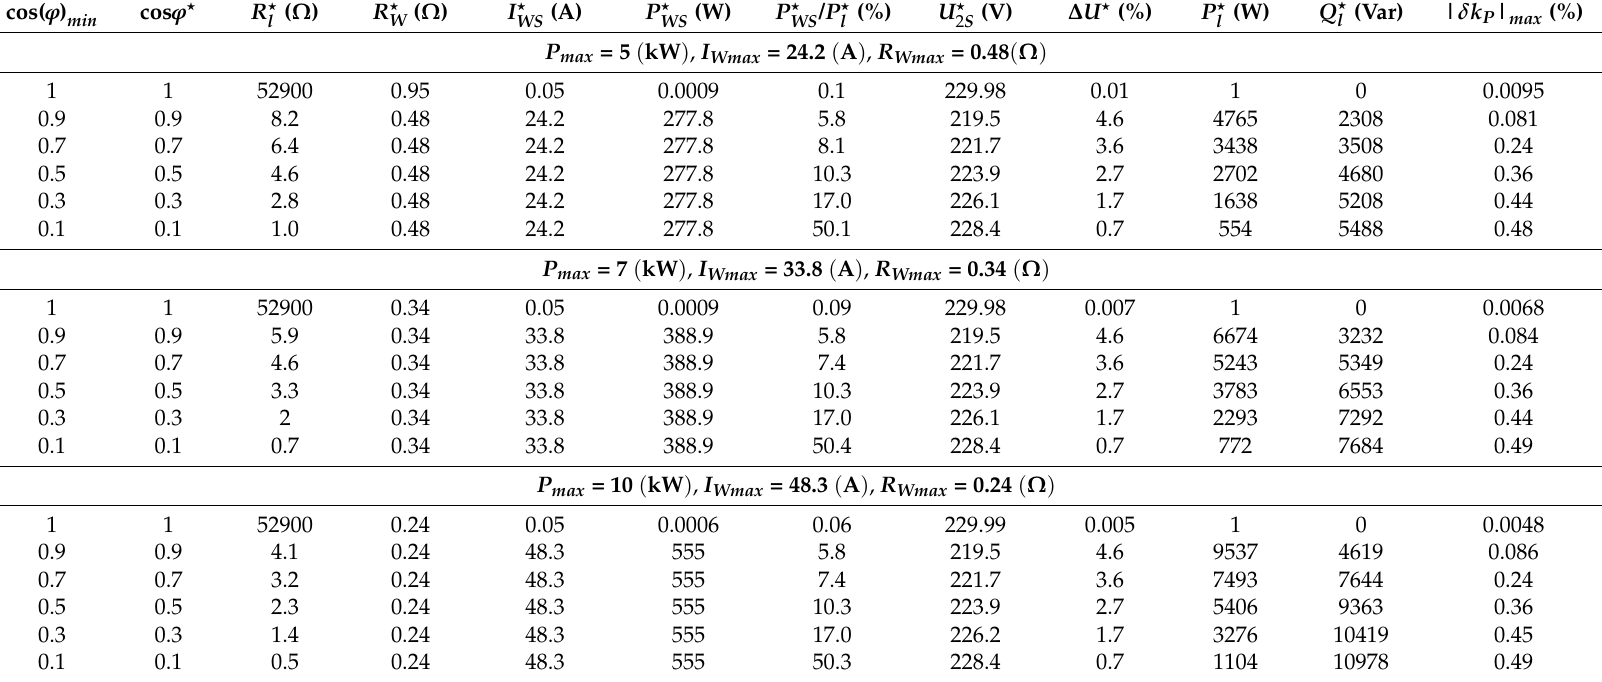
Table 2. The adjustment gain relative error dependence on the maximum rated load power 5 kW, 7 kW, and 10